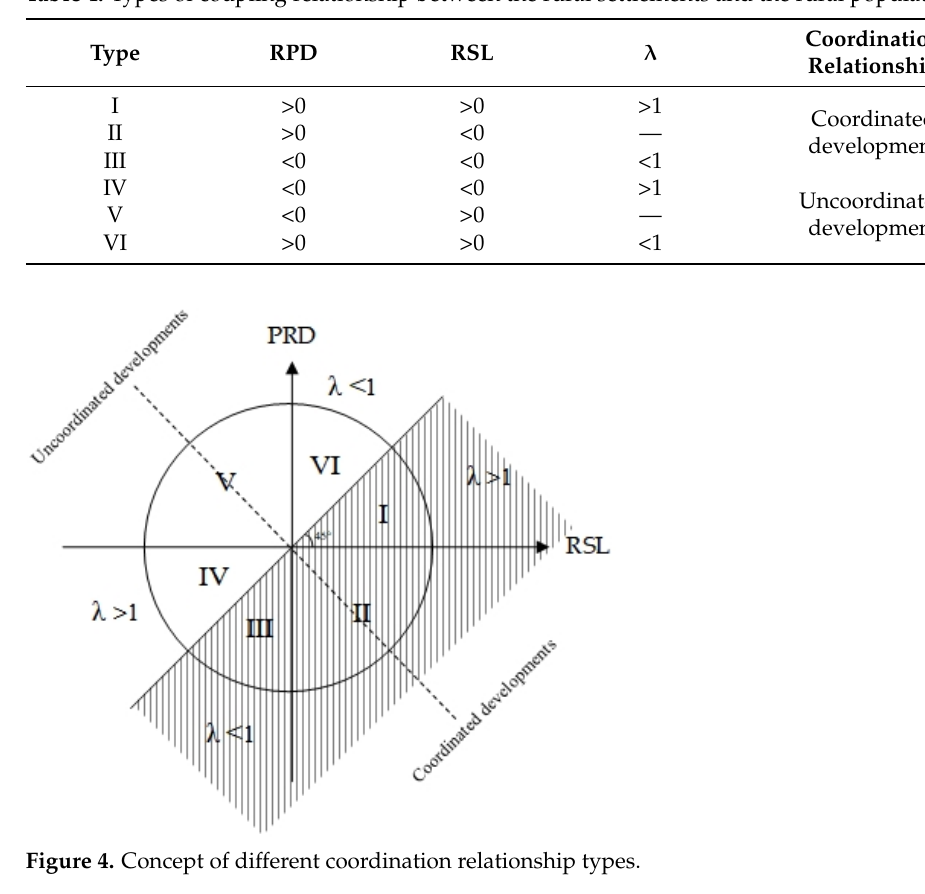
Table 4. Types of coupling relationship between the rural settlements and the rural population.